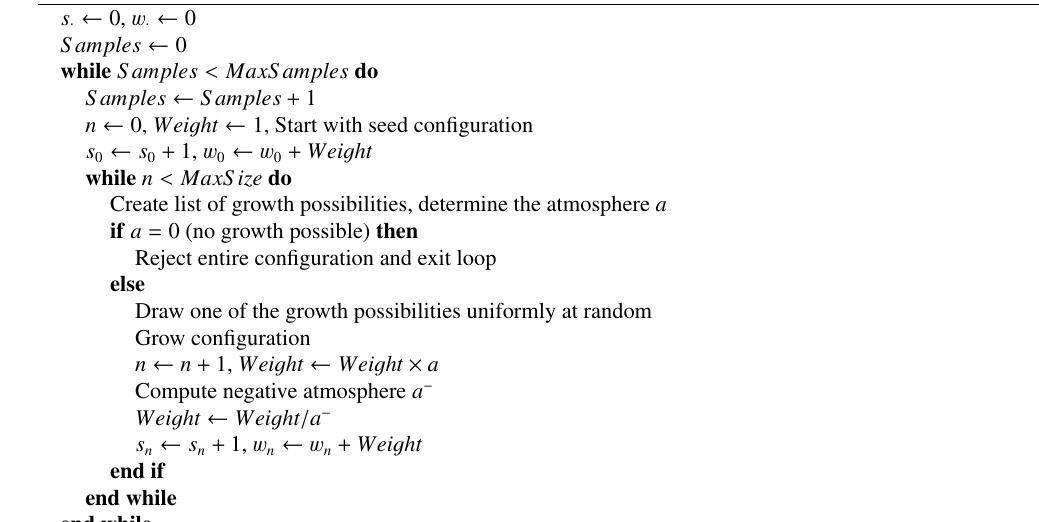
Algorithm 4 Generalised Atmospheric